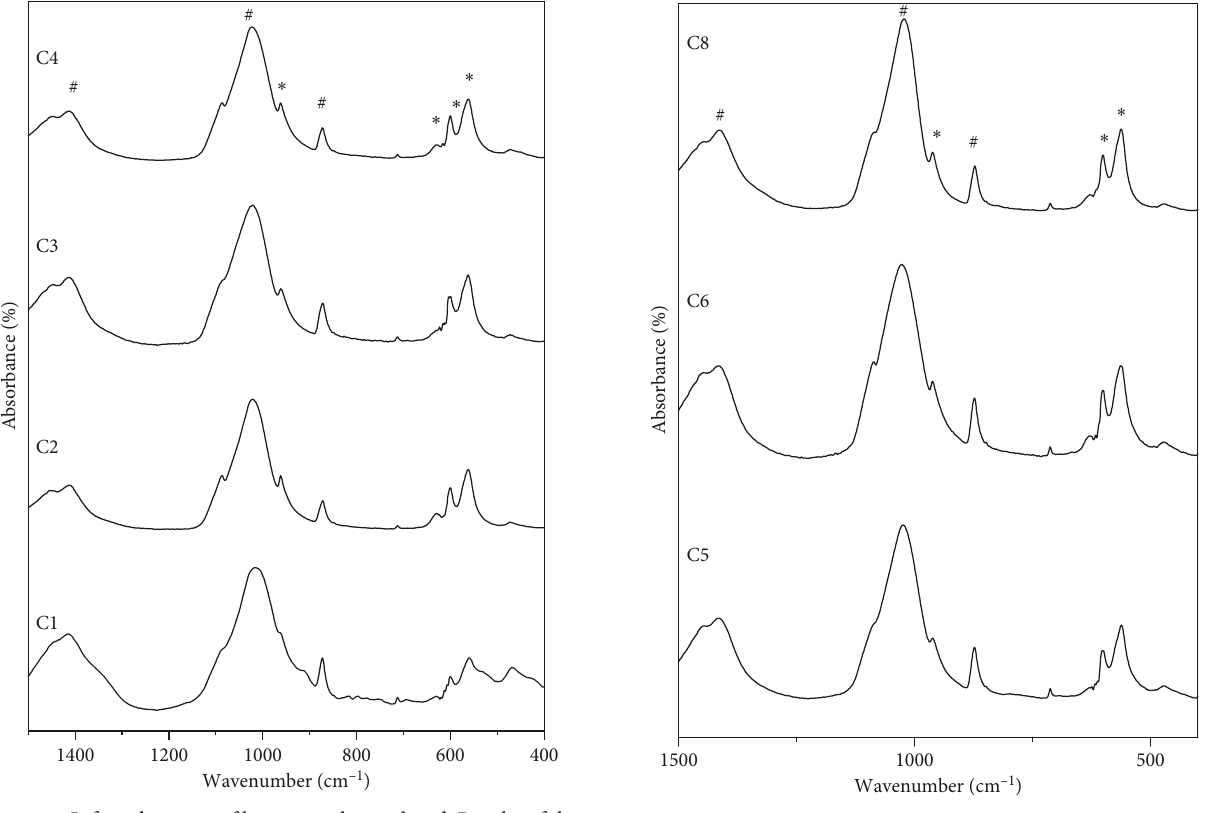
Figure 6: Infrared spectra of bone samples analyzed. Results of the samples from the layers C5, C6, and C8, where peaks of hy- droxyapatite ( ∗ ) (Ca 10 (OH) 2 (PO 4 ) 6 ) and calcite (#) (CaCO 3 ) are observed. Table 3: Average crystallinity index (CI X-ray ) and relative car- bonate/phosphate relative amount.